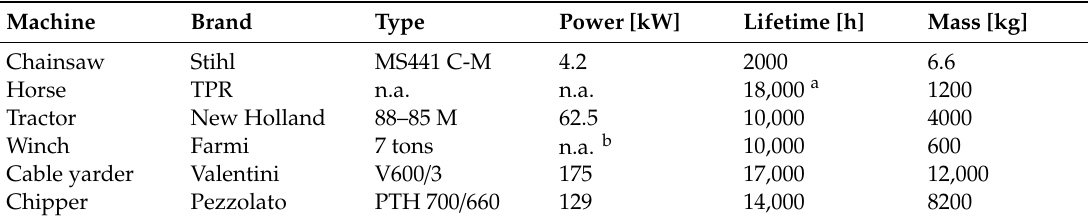
Figure 2. Extraction of whole trees in Mediterranean black pine plantations by ( a ) heavy rapid skidding horse; ( b ) forestry-fitted farm tractor with winch; and ( c ) double drum cable yarder. Table 1. Inventory relevant machinery and animal